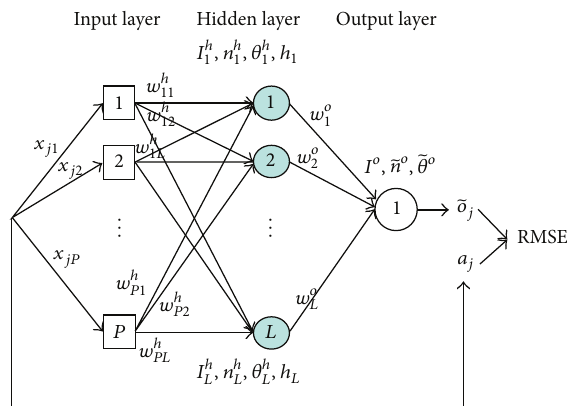
Figure 2: The architecture of the three-layer